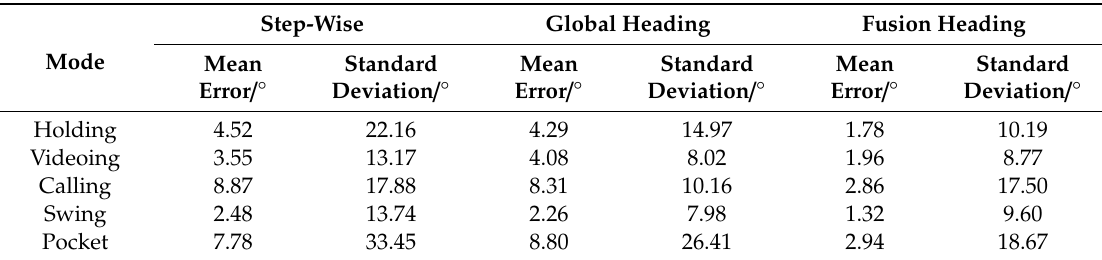
Table 4. Mean and standard deviation comparison of heading error for di ff erent heading estimation methods in five